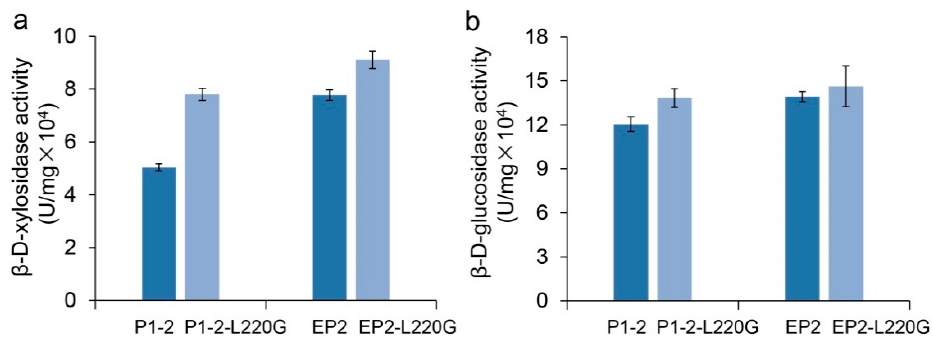
Figure 4. Specific activities of different L220G mutants against PNP-Xyl ( a ) and PNP-Glc ( b ). P1-2-L220G and EP2-L220G are the enzymes harboring L220G mutation. LXYL-P1-2 and P1-2-EP2 are used as controls, respectively. Data are the mean ± SD, n = 3. Table 1. Kinetic parameters for the hydrolysis of XDT by mutants harboring L220G